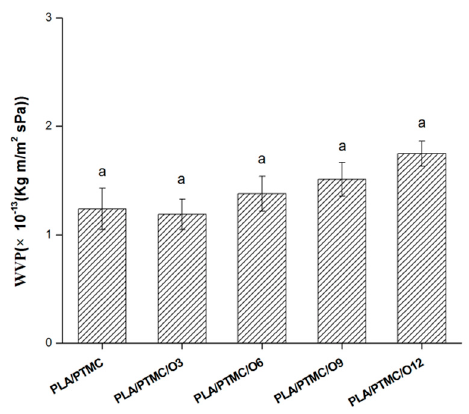
Figure 7. Water vapor permeability (WVP) of PLA/PTMC, PLA/PTMC/O3, PLA/PTMC/O6, PLA/PTMC/O9 and PLA/PTMC/O12 film. Values followed by same letter (a) was not significantly different ( p > 0.05).